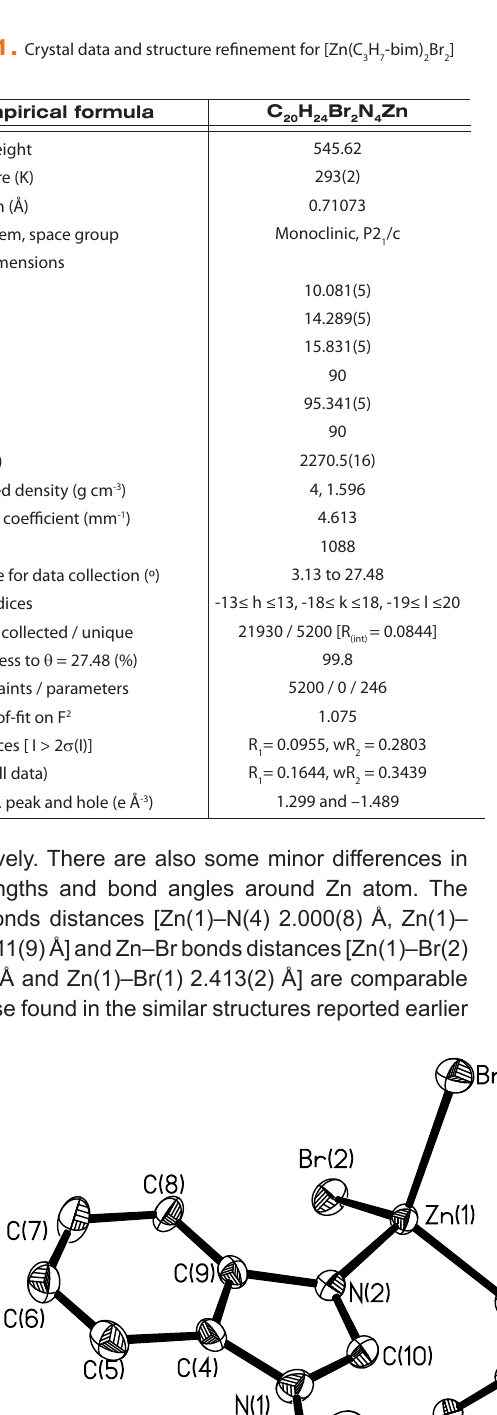
H -bim) Br ] with the atomic numbering 3 7 2 2